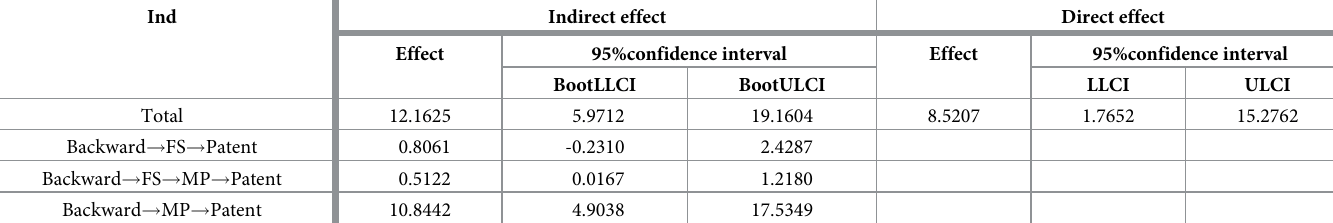
Table 7. Chain intermediary test of financing structure and market power with backward